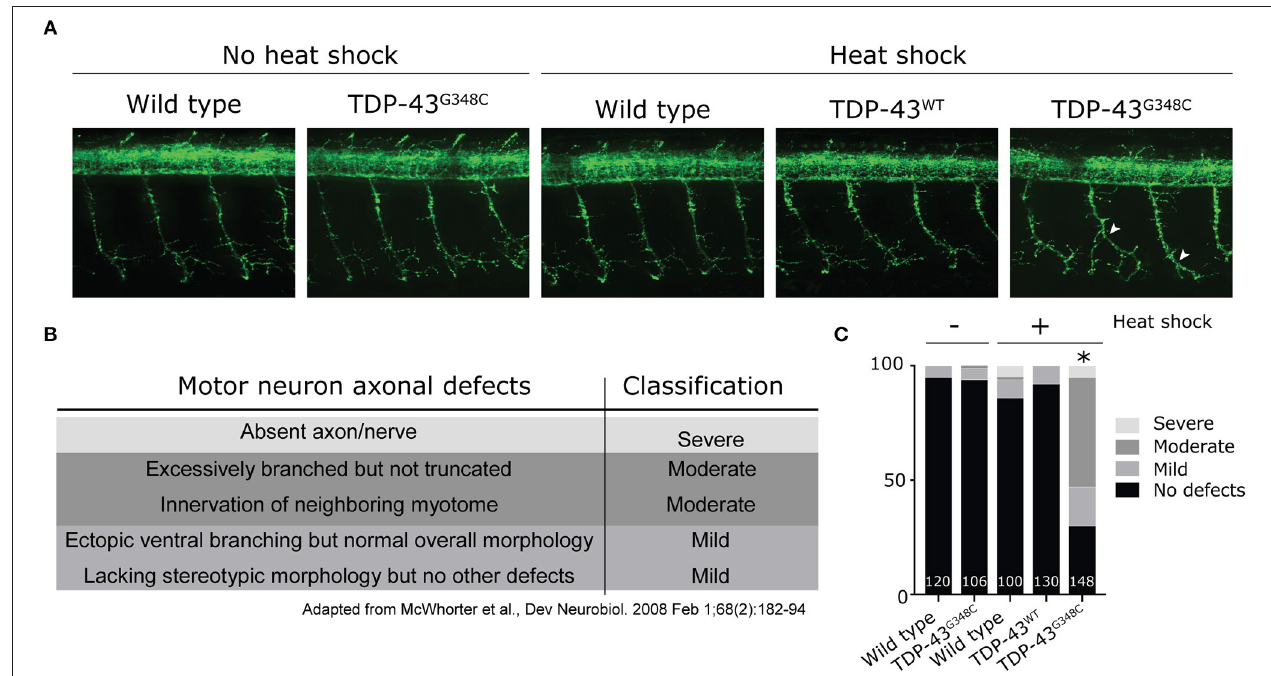
FIGURE 3 | Abnormal development of motor neuron axons in zebrafish expressing TDP-43 G348C . (A) Immunohistochemistry against znp-1 in 2 dpf whole-mount embryos. The 3-to-4 somites spanning the anus are shown with the axons of the motor neuron expanding down from the spinal cord. White arrow heads indicate abnormal premature branching of the main axonal branch and absence of secondary branching in transgenic embryos expressing TDP-43 G348C , compared to embryos expressing TDP-43 WT or not expressing any transgene. (B) Classification criteria used for the quantification of defects. (C) Quantification of axonal defects based on the classification found in (B) . The total number of axons analyzed is indicated; The three axons spanning the anus were analyzed in at least 30 embryos over the course of three experiments. Chi-square analysis was performed between the different conditions, * p -value < 0.05.